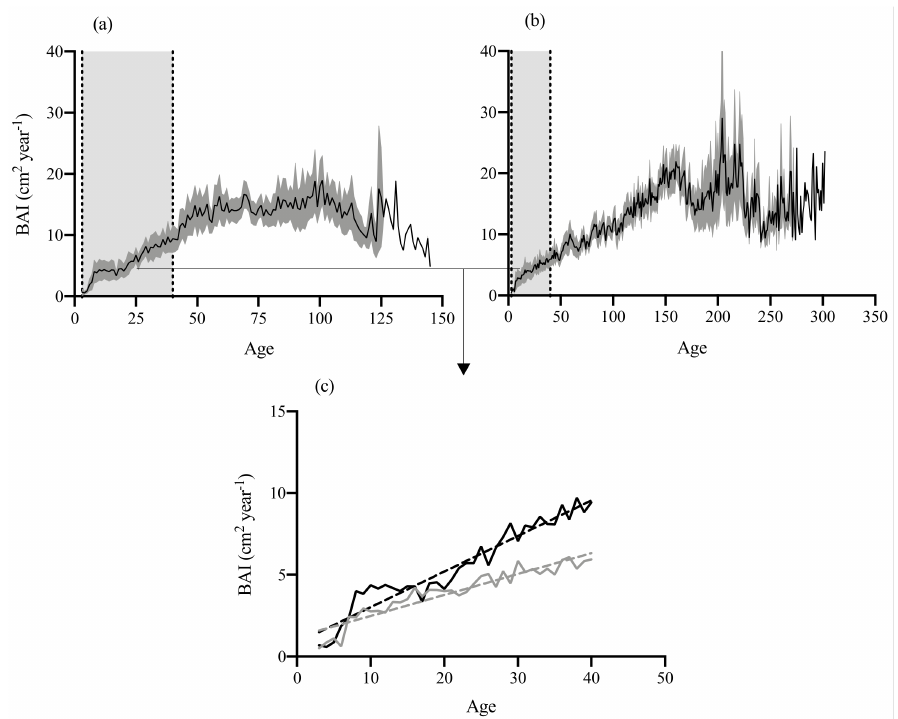
Figure 2. Course of mean basal area increment (BAI) against age. ( a ) P. kesiya ; ( b ) P. dalatensis . Vertical grey bars mark the juvenile stage of the trees. Standard errors (SEs) are indicated by grey areas , means without SEs originated from 1 tree. ( c ) Correlation between the mean BAI of the species and age during their juvenile periods (age 3 to 40) with dashed lines indicating linear regressions: black lines , P. kesiya (BAI = 0.2180age + 0.8312); grey lines , P. dalatensis (BAI = 0.1283age + 1.194). The slopes of the two regression lines differ significantly.